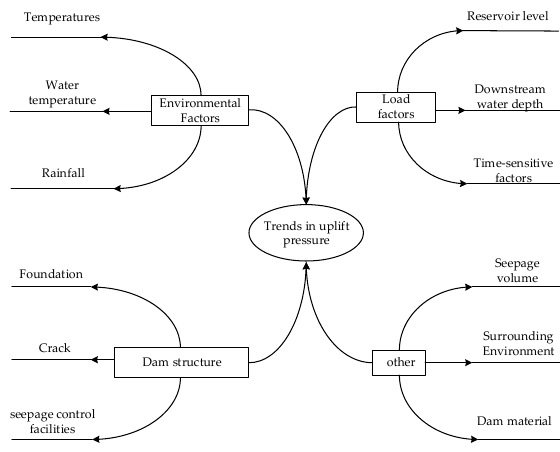
Figure 1. Factors affecting the amount of dam uplift pressure